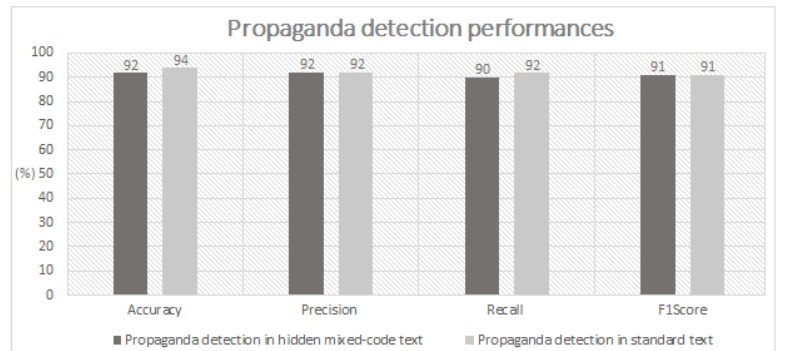
Figure 8. Results evaluation using